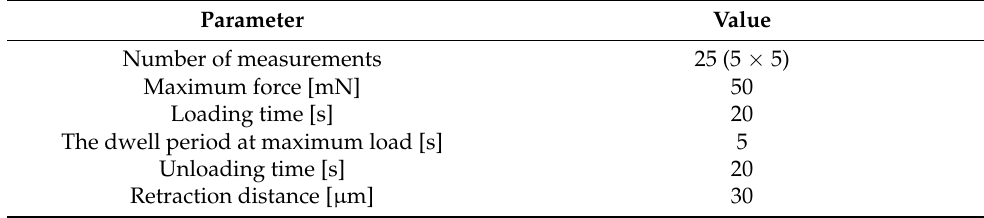
Table 4. The parameters of nanoindentation tests.